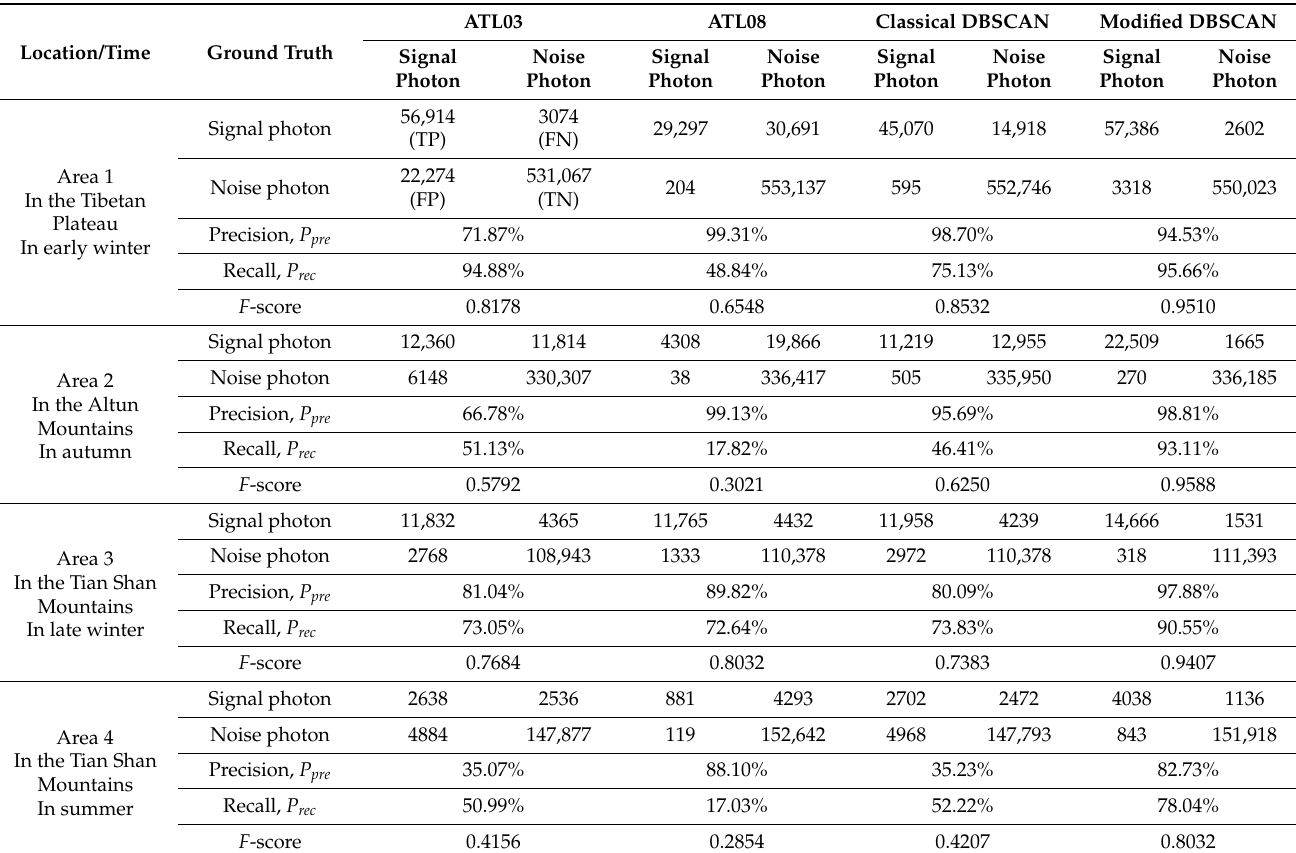
Table 3. Quantitative comparison results of the four signal extraction methods in the four study areas.